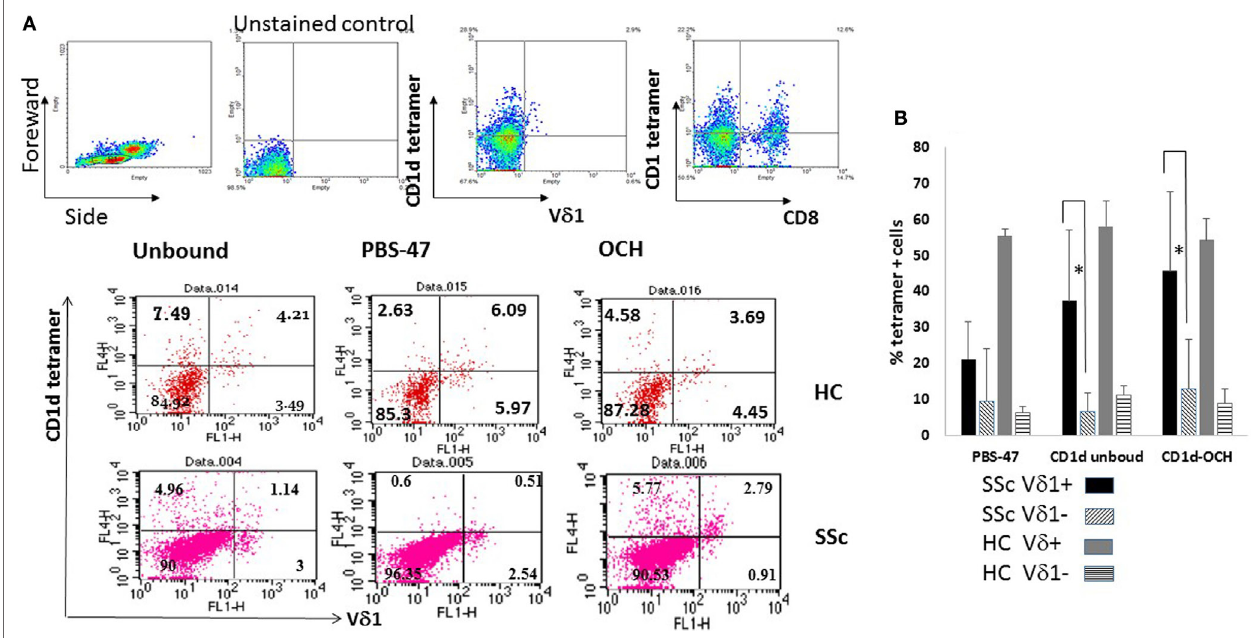
FigUre 4 | CD1d tetramer binding to cultured V δ 1 + T cells in systemic sclerosis (SSc) patients and healthy controls (HCs). (a) The upper panel shows gating strategy for analysis of CD1d tetramer binding using HC peripheral blood mononuclear cells (PBMCs) cultured in FM containing interleukin-2 (IL-2) 100 IU/ml for 6 days. Cells selected from the lymphocyte gate as indicated in the Forward/Side scattergram on the left were analyzed untouched or after staining with the CD1d unbound tetramer and monoclonal antibody (mAb) to either V δ 1 or CD8. The second and third panels represent flow cytometric dot plots of PBMC of a HC and SSc patient (patient 1; Table 1 ) cultured in FM containing IL-2 100 IU/ml for 6 days. The cells were stained with APC labeled CD1d tetramers (unbound, PBS-47 and bound to OCH) as indicated above the dot plots and V δ 1-FITC. Percent cells in quadrants set according to a non-stained control are shown. (B) Bars represent mean and 1 SEM of %V δ 1 + and V δ 1 − cultured cells binding the indicated tetramers in cultures as described in Figure 4a for five SSc patients and two HCs. * denotes p < 0.05 for adjacent indicated